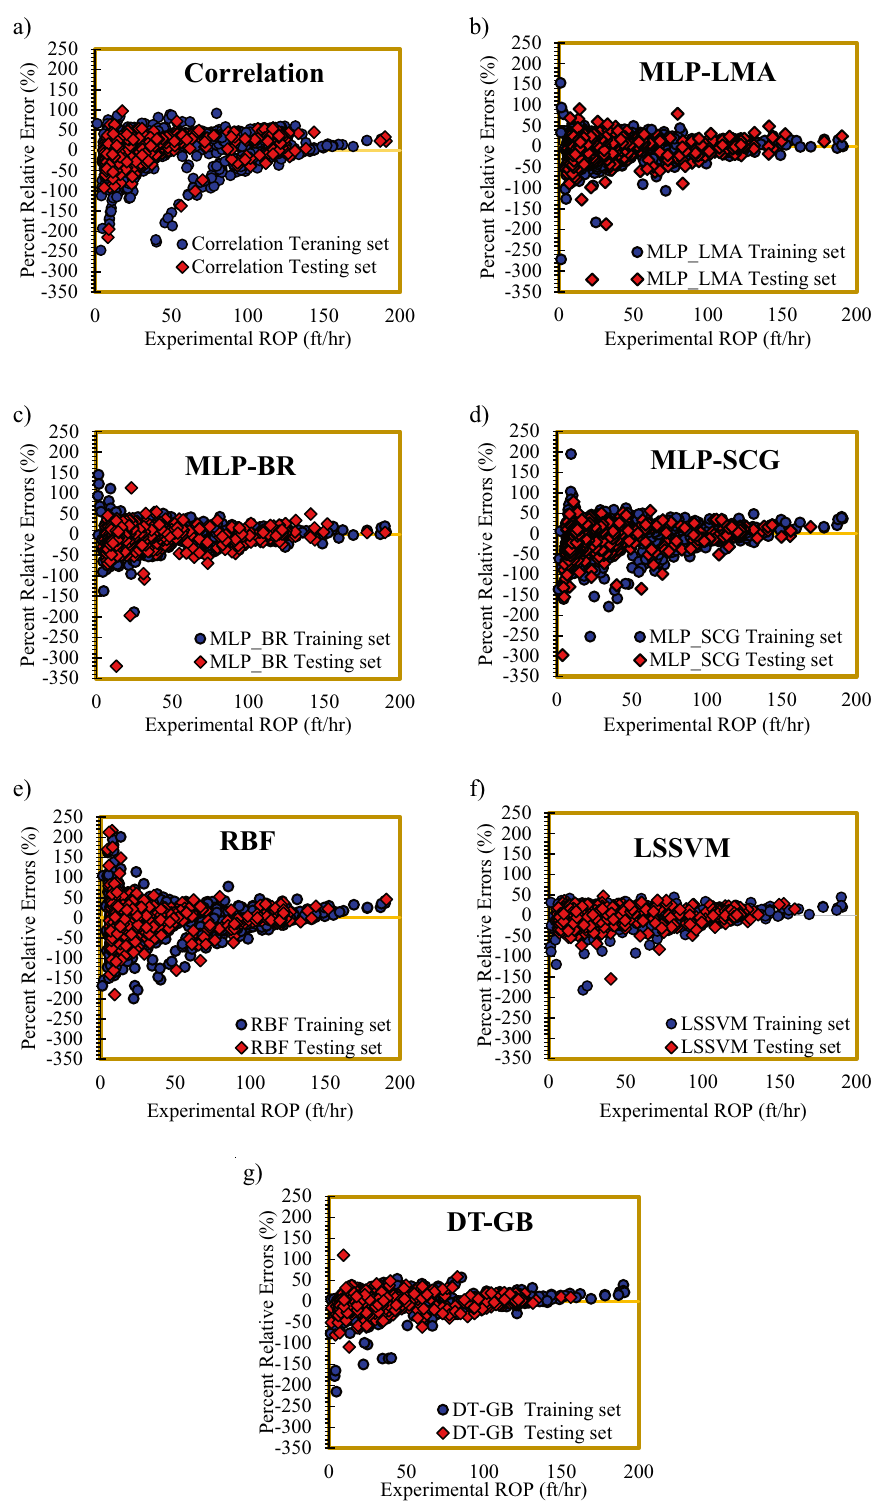
Figure 10. Error distribution plots of the proposed